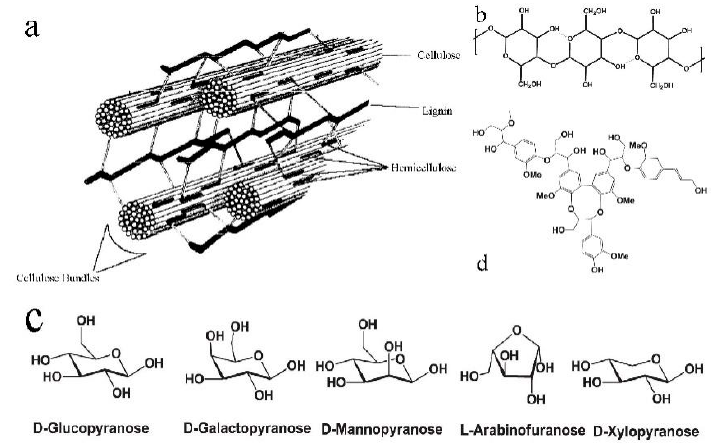
Figure 1. ( a ) Structure of plant cell walls [8]; ( b ) structure of cellulose [9]; ( c ) basic units of hemicellulose [9]; and ( d ) simple structure of lignin [9] .